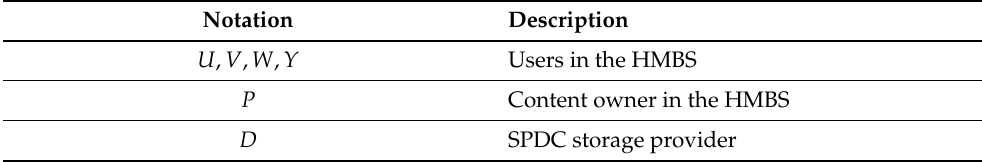
Table 2. A list of notations that represent